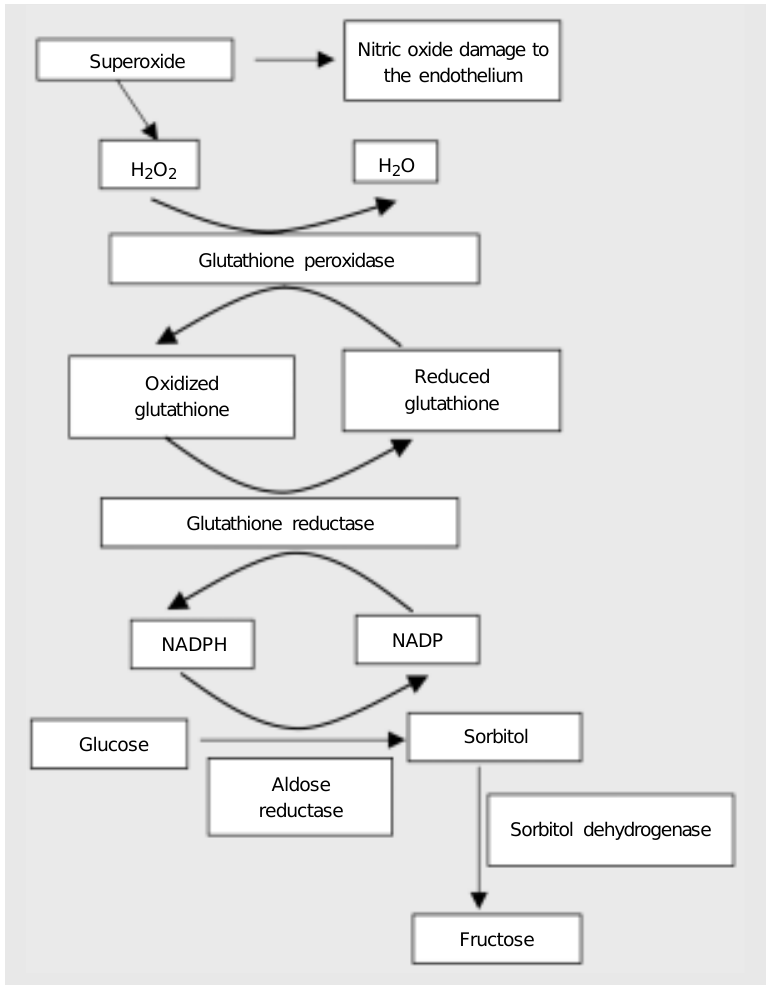
Figure 1. Schematic presentation of a hypothetical polyol